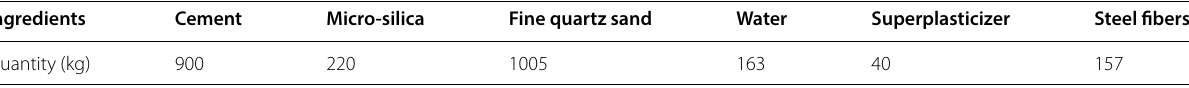
Table 4 Mixture proportions of UHPC for 1 m 3 (Ahmad et al.